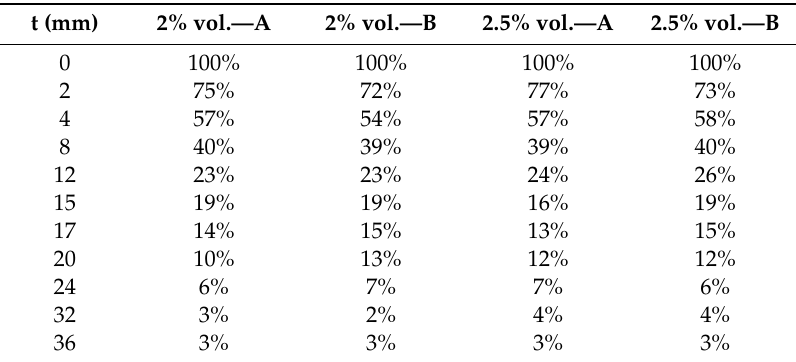
Table 4. Average attenuation factors calculated for each group.